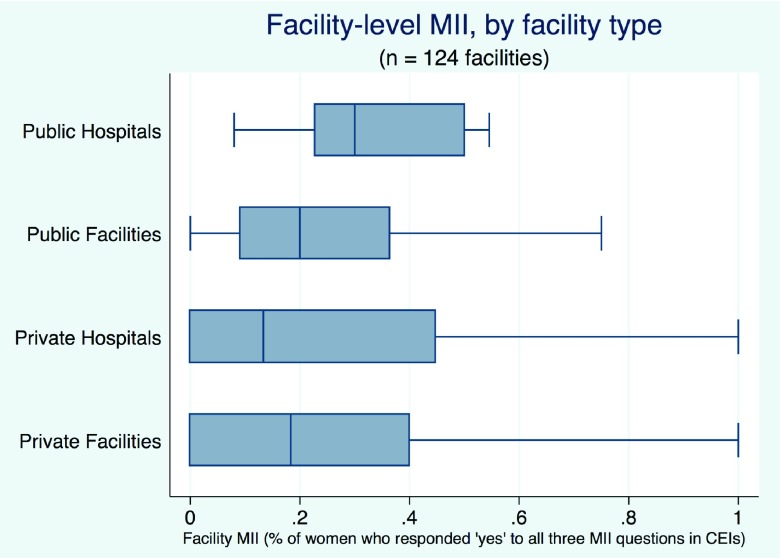
Distribution of facility-level Method Information Index (MII) scores, by facility type.Minimum, median and maximum scores are indicated.